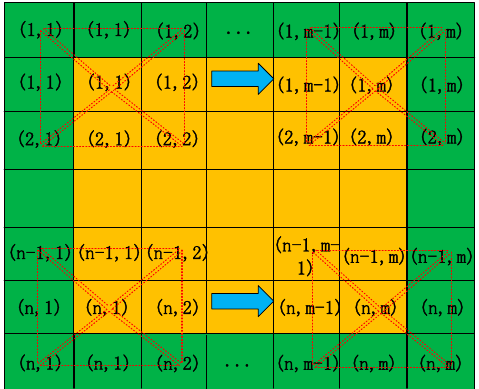
Figure 6. Filter template processing.